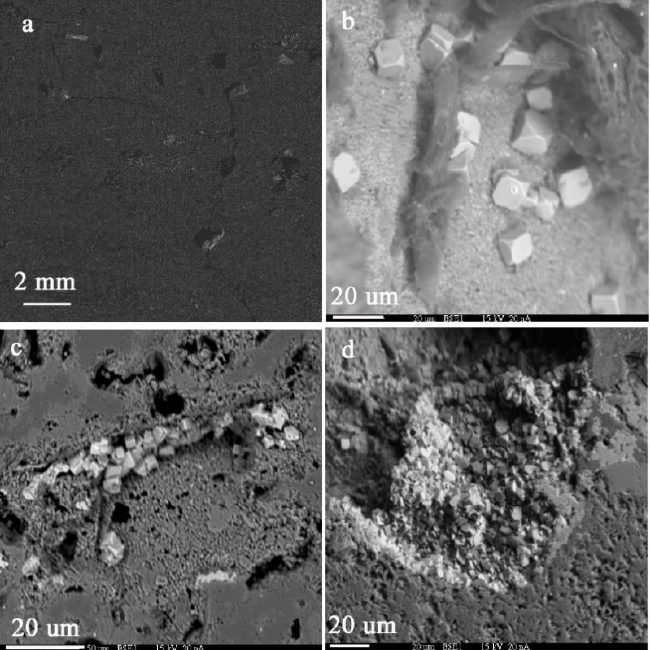
Figure 3. Arsenic minerals in the rock. ( a ) Arsenic X-ray map shows the distribution of arsenic minerals (bright patches in the rock, mainly in the vesicle areas). ( b – d ) Arsenogoyazite crystals gather in the cavities.